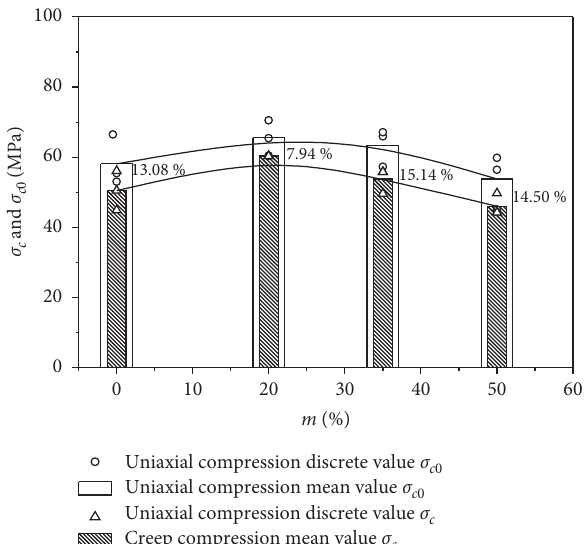
Figure 5: Creep peak stress ( σ c ) and conventional uniaxial com- pression peak stress ( σ c0 ) of concrete with different fly ash re- placement